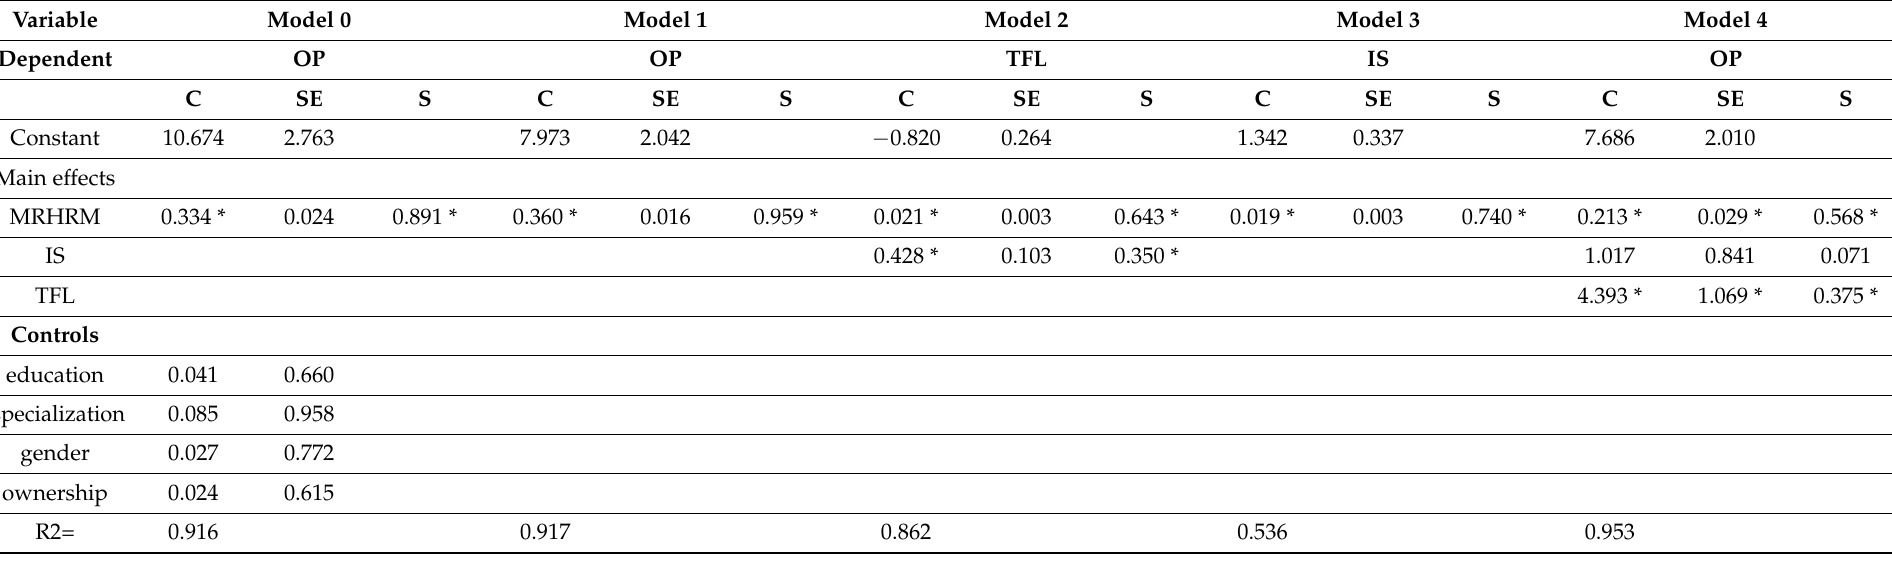
Table 2. Regression results for main effects and mediation